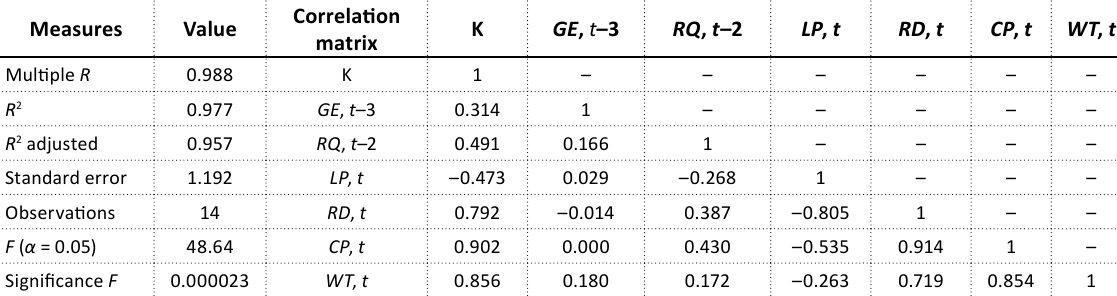
Table 2. Descriptive statistics and correlation matrix